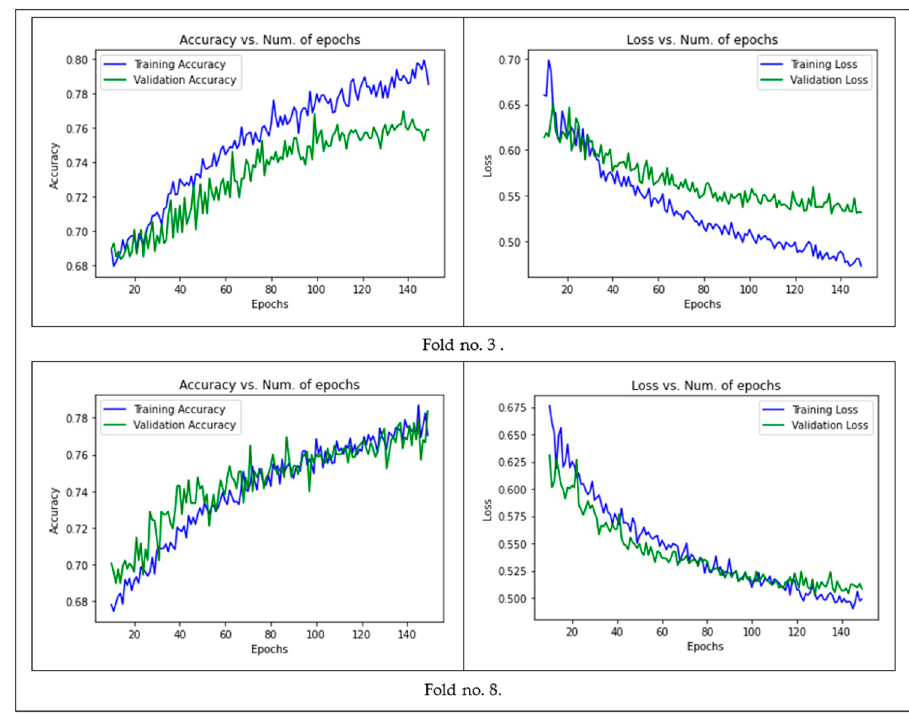
Figure 5. Training/validation accuracy and loss of the image-CNN model across the epochs.